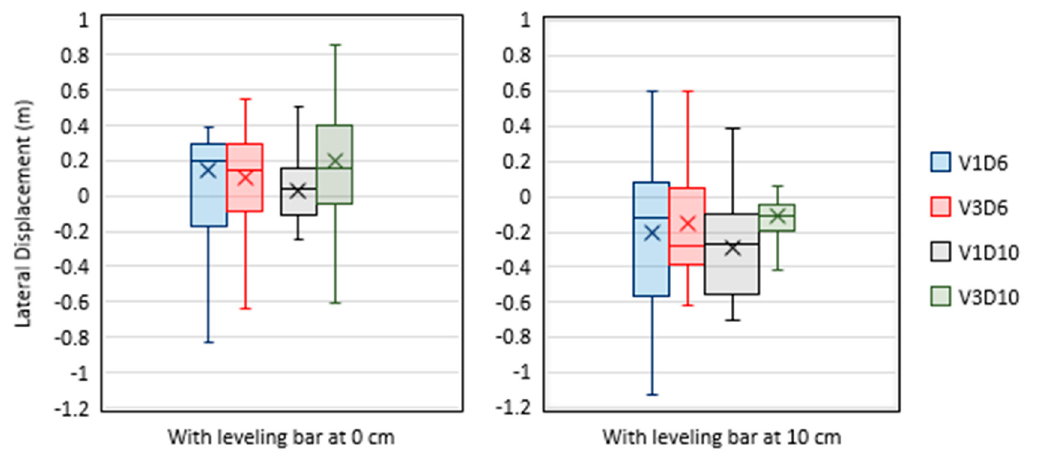
Figure 6. Average trackers lateral movement at different working conditions.